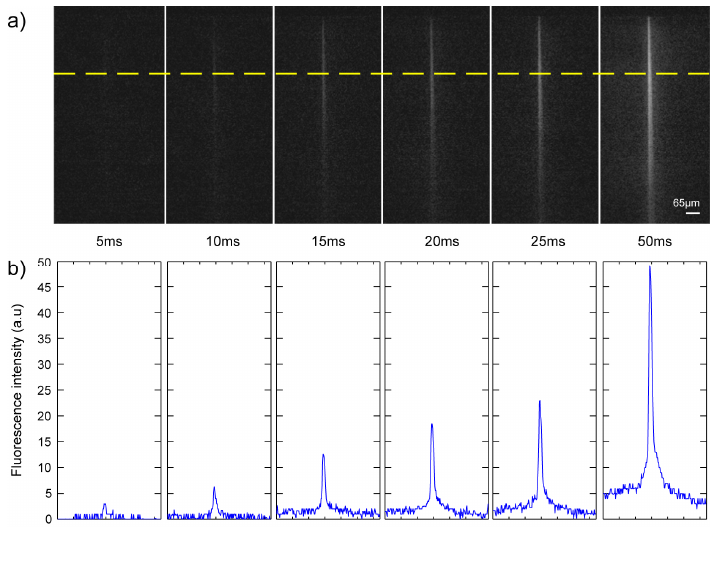
Figure 6. Optical uncaging of a caged fluorescent compound. (a) Fluorescence pictures of the activated region for six different pulse durations. (b) Transversal profile of the fluorescence intensity along dashed line for different excitation energies. Scale bar is 65µm for all